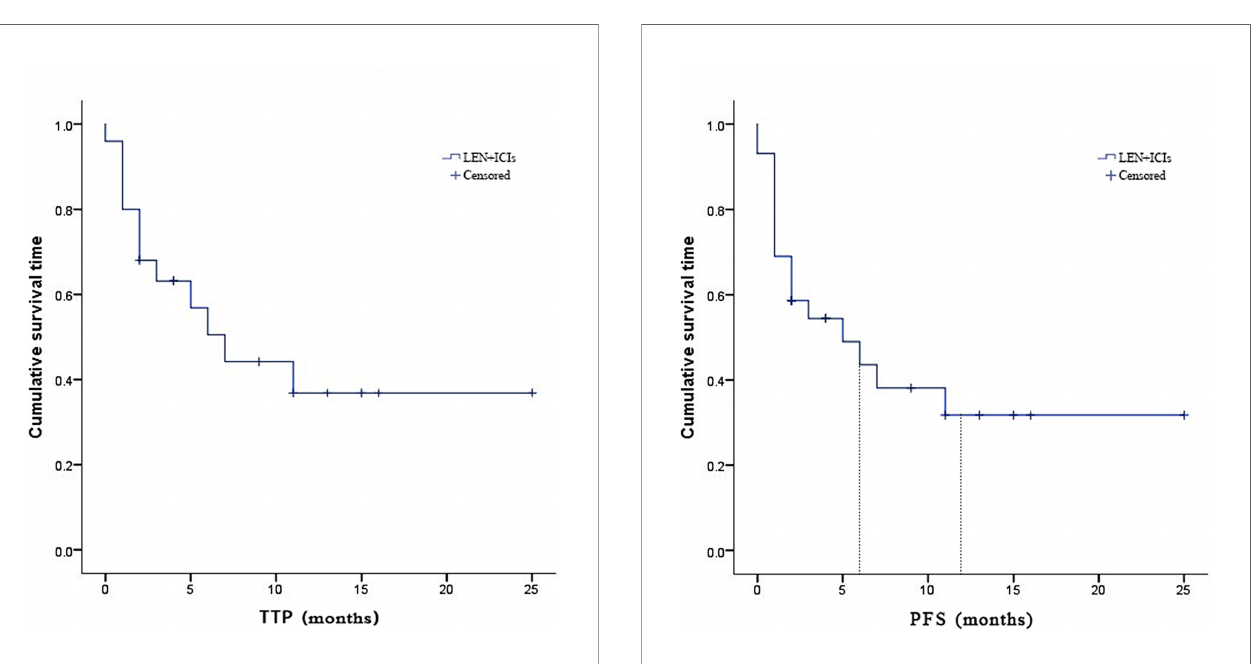
vs pembrolizumab, n = 15 [93.8%] vs n = 9 [69.2%]) or high- grade (Group nivolumab vs pembrolizumab, n = 7 [43.8%] vs n = 5 [38.5%]) adverse events was similar between LEN plus